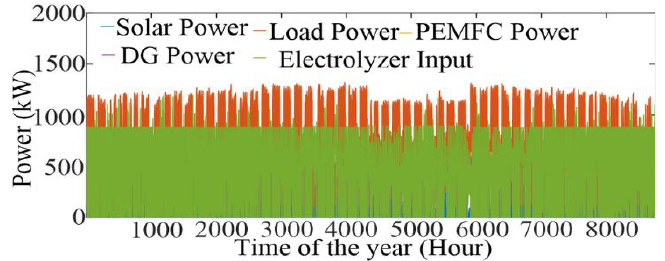
Figure 12. Power generation and consumption over the year: combination 3.